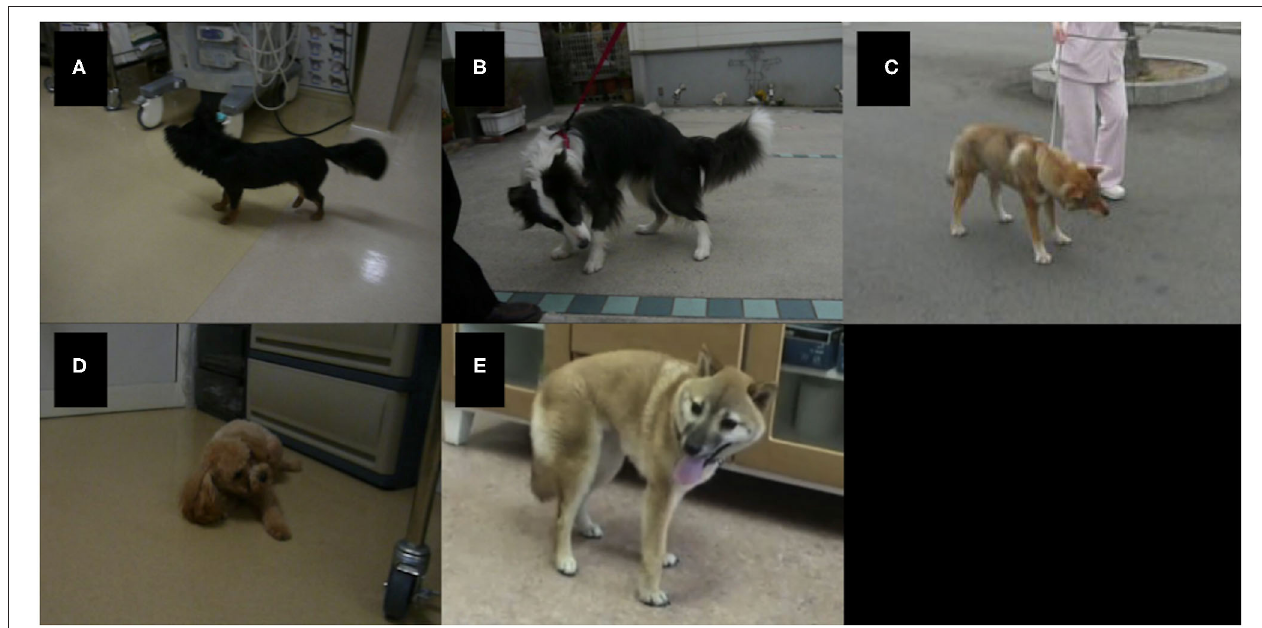
FIGURE 2 | Positioning head tilt observed in dogs with lysosomal storage diseases. The heads of all dogs tilt to opposite sides when turning to one side. (A) A Chihuahua with neuronal ceroid lipofuscinosis (NCL) (Case 1, 19 months of age); (B) a Border Collie with NCL (Case 3, 16 months of age); (C) a Shikoku Inu with NCL (Case 5, 46 months of age); (D) a Toy Poodle with GM2 gangliosidosis variant 0 (Sandhoff disease) (Case 7, 18 months of age); (E) a Shiba Inu with GM1 gangliosidosis (Case 9, 6 months of age).